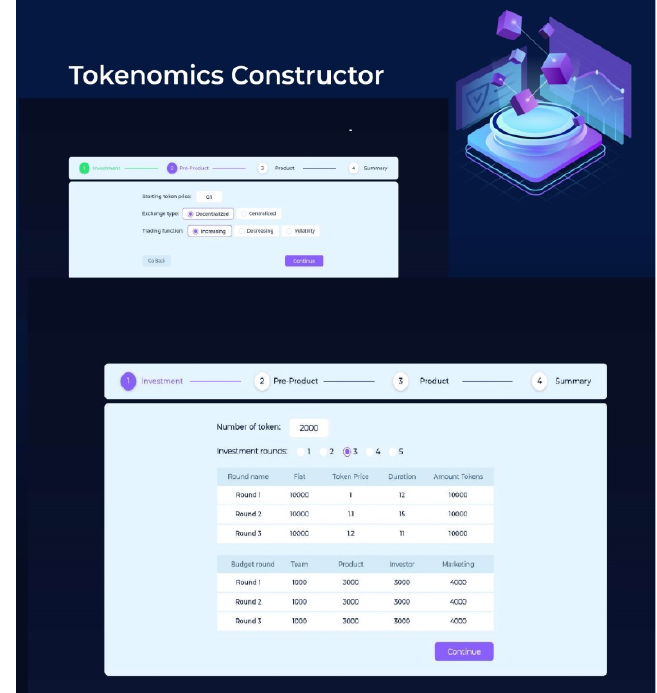
Figure 4. Tokenomics constructor site fragment